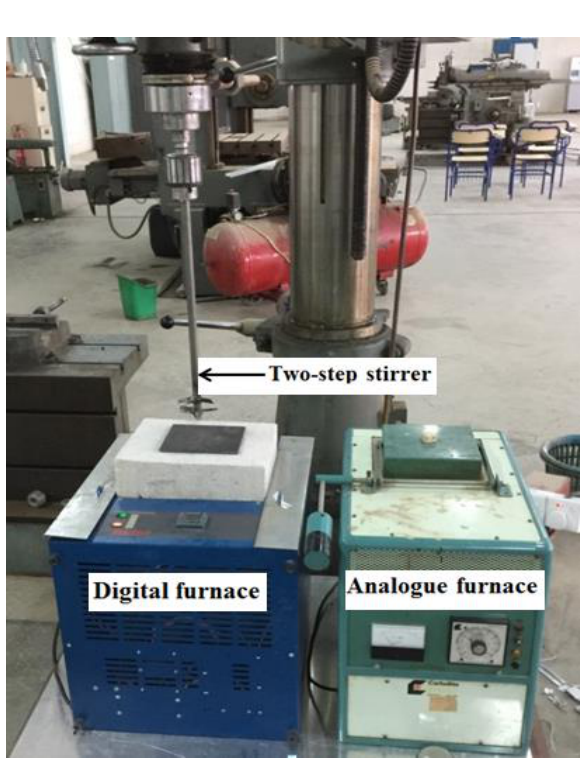
Figure 2: Experimental techniques.